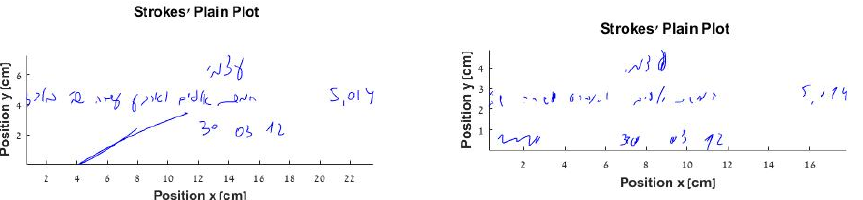
mean pen-stroke width of 0.10 for an s.PD-MCI patient.